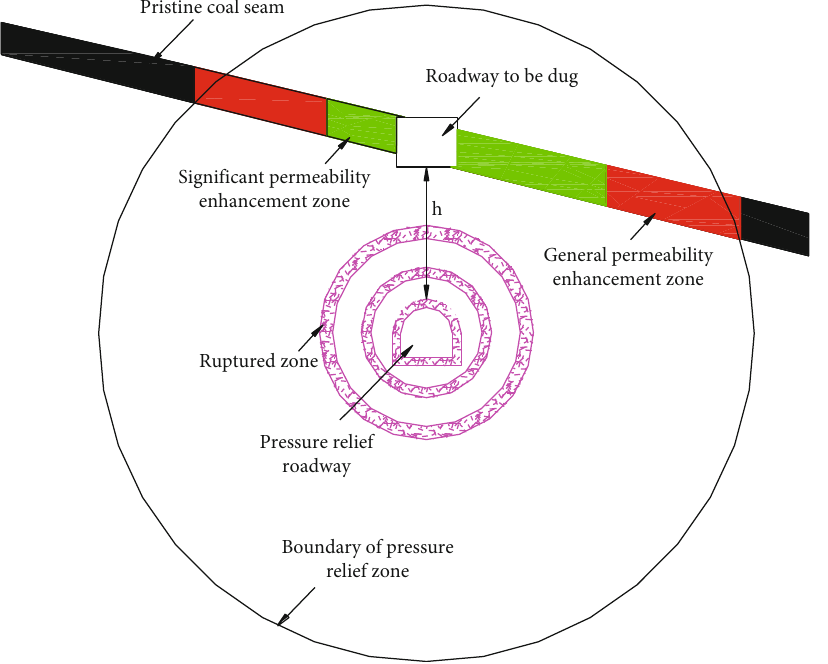
Figure 1: The model of pressure relief roadway for deep coal roadway strip.